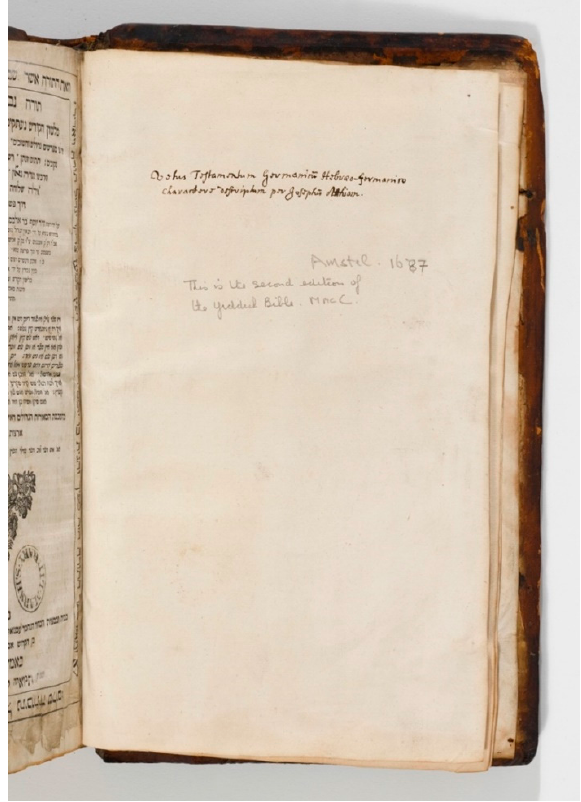
Figure 20. Yiddish Bible; Marsh’s Library C.3.2.25.